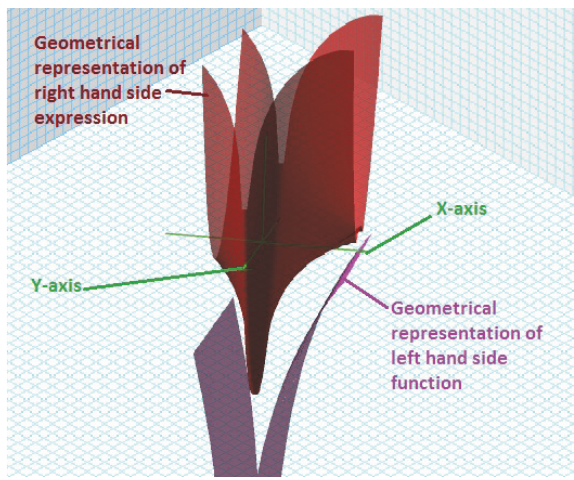
Figure 6: Plot showing domination of right hand side function over left hand side